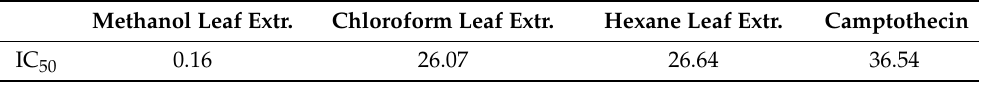
Table 3. IC 50 values of methanol, chloroform and hexane extract of D. villosa leaf against MCF-7 cell. Methanol Leaf Extr. Chloroform Leaf Extr. Hexane Leaf